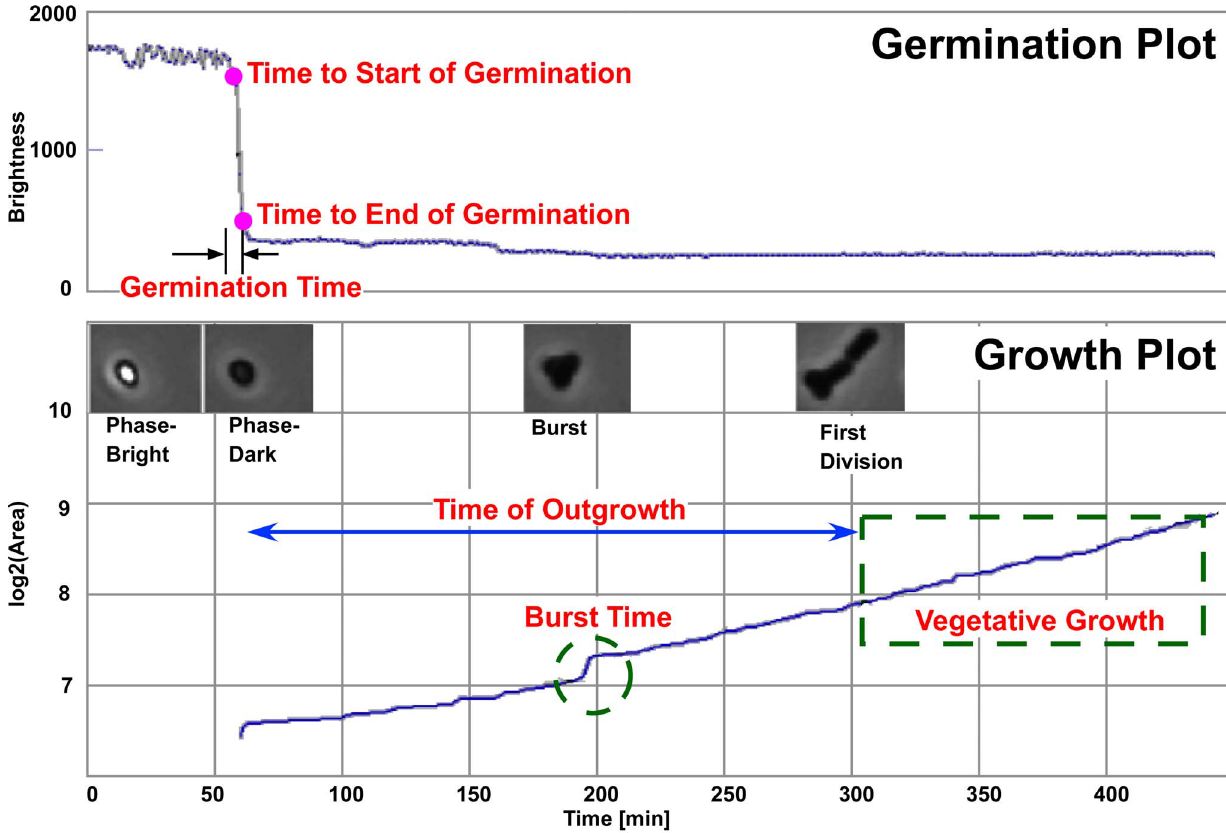
Figure 2. Dual plot showing spore germination and outgrowth of one heat-activated B.subtilis 1A700 spore as analyzed with SporeTracker. Above: Phase-bright to phase-dark transition, marked with a small circle at 90% (start of germination) and 10% (end of germination) of the entire (pixel) intensity drop range (brightness). Below: various snapshots at different stages of germination and outgrowth. The exponential growth phase (appearing linear in the log 2 transformed plot of the measured area) is used to calculate the generation time. The burst of the cell out of the spore coat is accompanied by a relative short and significant increase in area (marked by the green circle). In SporeTracker, the cursor can be dragged across such a plot to observe live the various phases of spore germination and outgrowth and subsequent growth of the corresponding cell.